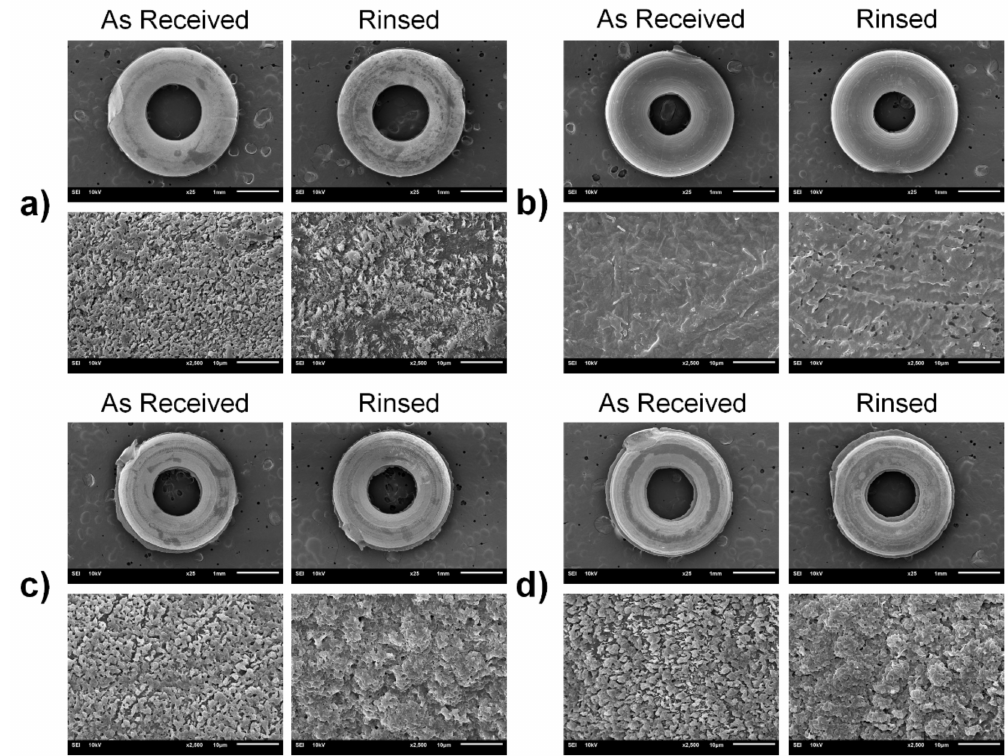
Figure 7. Representative top-view images of the samples taken by scanning electron microscope (SEM) of the as-received sample and the sample rinsed with Mouthwash 2: ( a ) Brand A; ( b ) Brand B; ( c ) Brand C; and ( d ) Brand D. Top-row images of each brand were taken at 25 × (Scale bar = 1 mm). Bottom-row images of each brand were taken at 2500 × (Scale bar = 10 µ